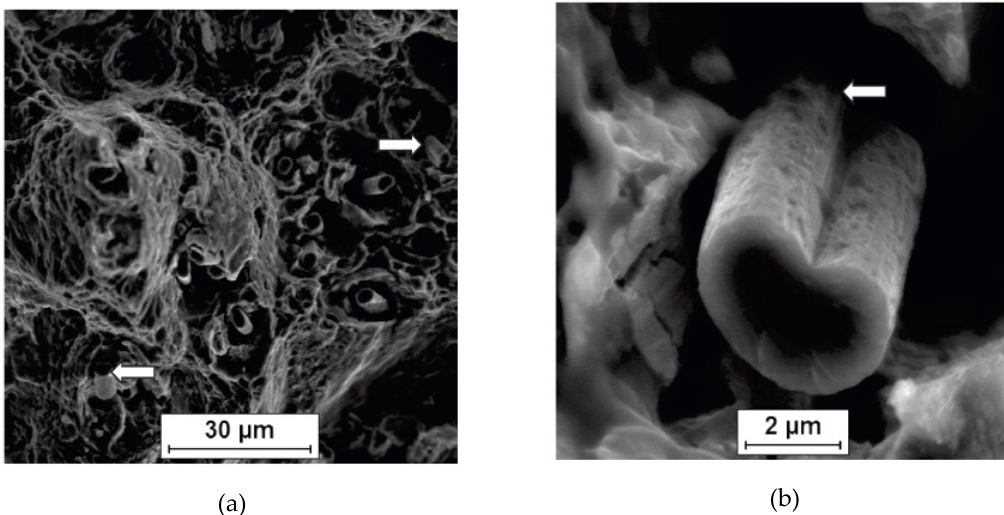
Figure 6. SEM micrographs of Mg-Csf composite KoBo-extruded after strength test demonstrated effect of carbon fibers fragmentation. (a) very short fibers in pseudo-ductile matrix, (b) single fractured fiber.